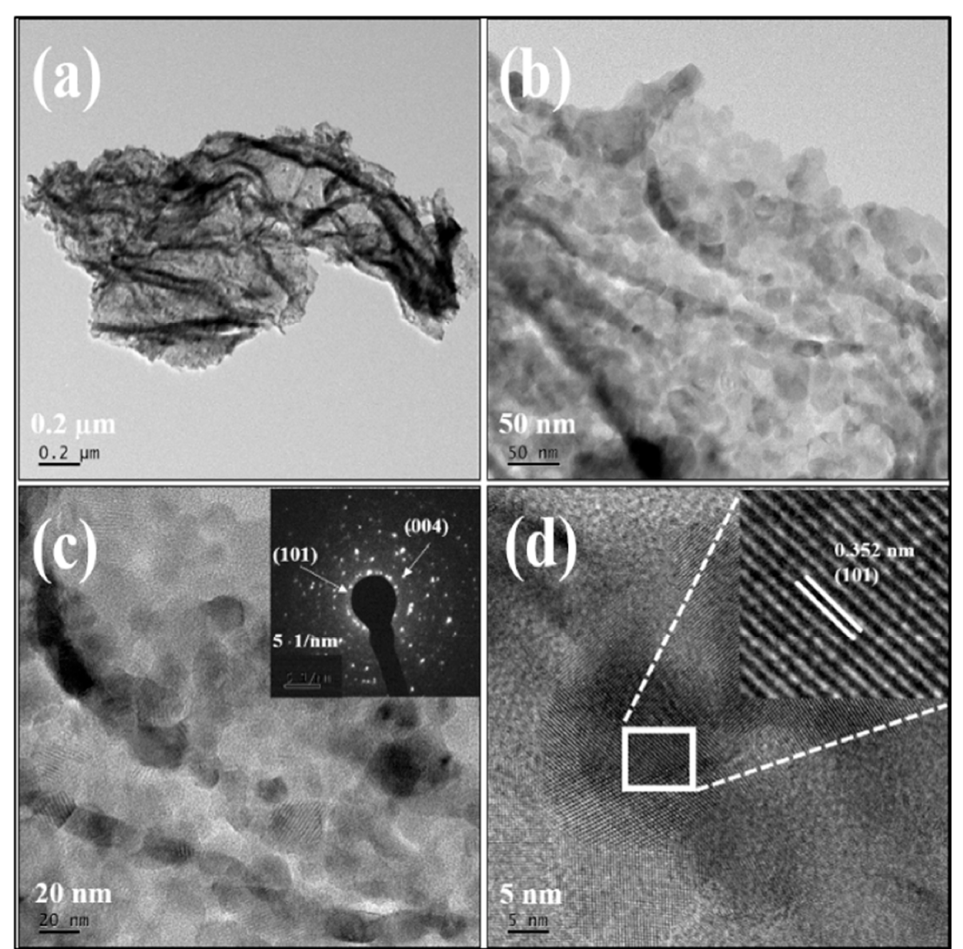
Figure 6. ( a,b ) FE-TEM images of pure TiO 2 , insets of ( c ) and ( d ) are the SAED and high-resolution TEM.